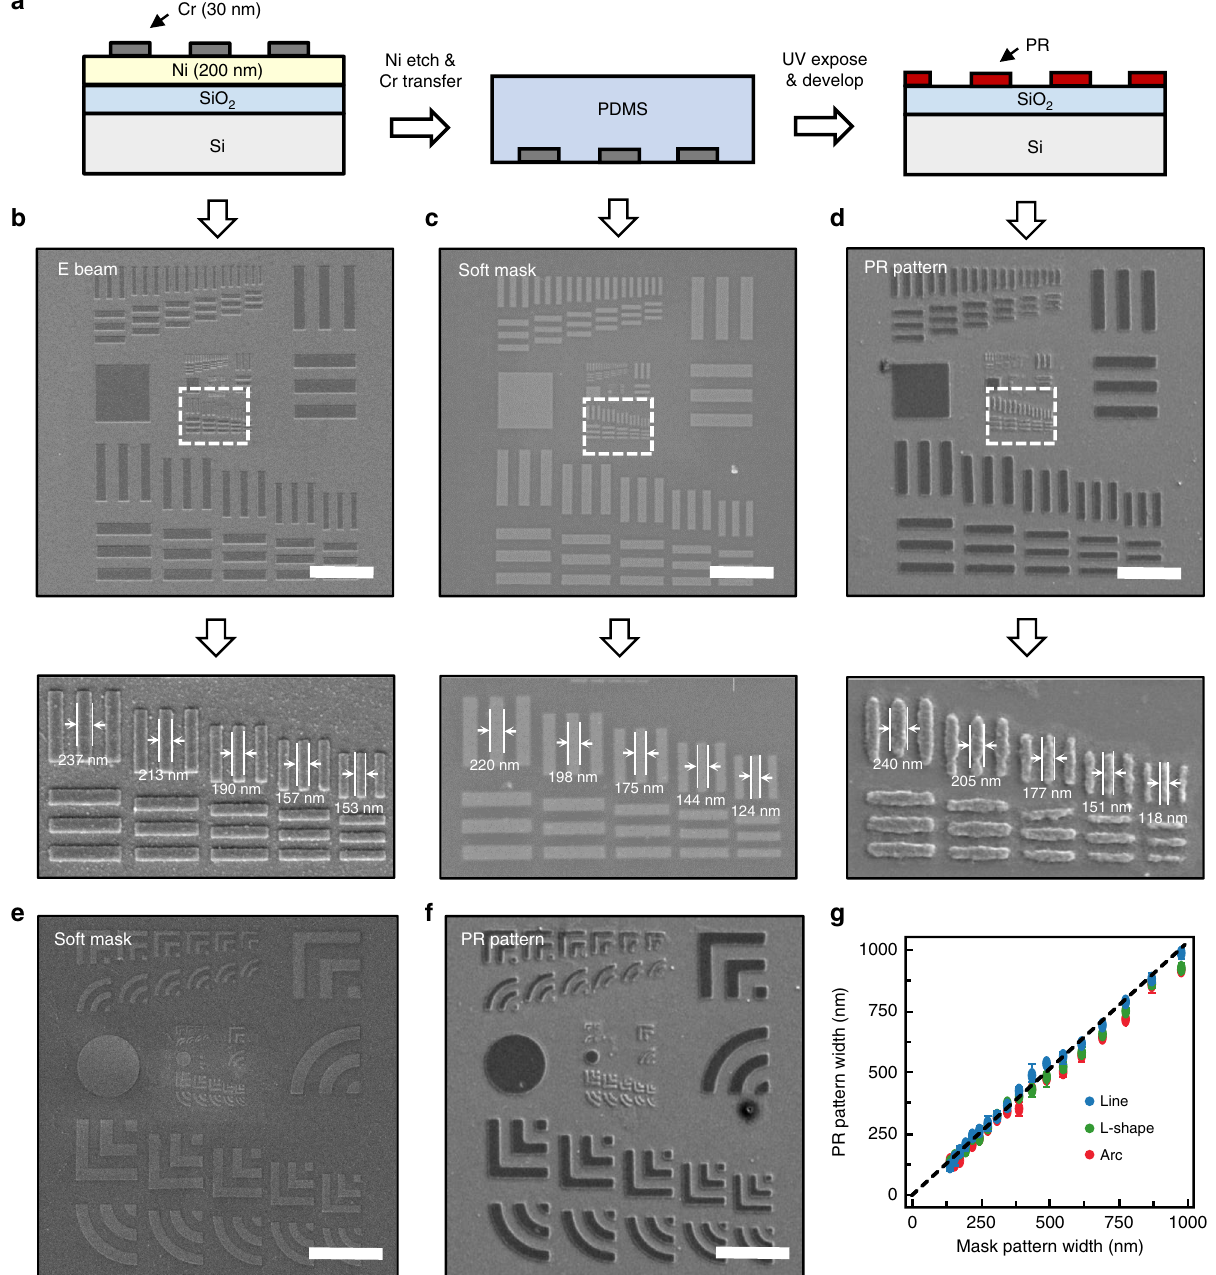
Fig. 4 Soft photomask to quantitatively resolve sub-diffraction surface features. a Schematic illustration of transferring steps during optical lithography by the soft photomask. b – d SEM images of the 1951 USAF resolution test chart at each transferring step illustrated in ( a ), i . e., de fi ning Cr patterns by e-beam lithography ( b ), Cr patterns embedded in a PDMS mask ( c ) and the photoresist pattern ( d ). The lower panels show magni fi ed images of the parts of the upper panel images indicated with dotted squares. Scale bar: 5 μ m. e SEM image of modi fi ed 1951 USAF resolution test chart for arc and L-shaped pattern in soft photomask. Scale bar: 5 μ m. f SEM image of patterned photoresist feature corresponding to ( e ). Scale bar: 5 μ m. g Average width of patterned photoresist features depending on Cr pattern width. Error bars indicate a maximum and minimum value in the experiment results and the dotted line is guiding line ( y = x